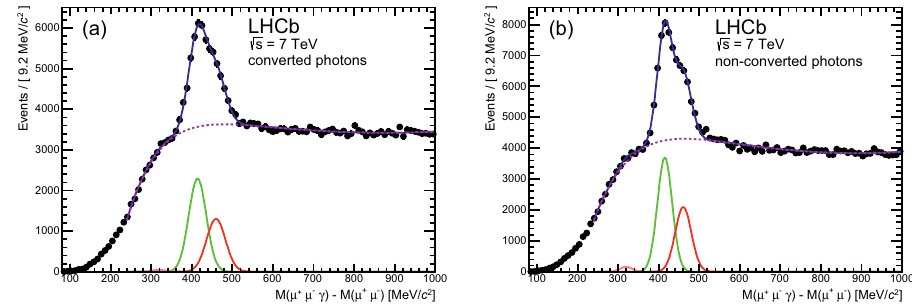
Figure 19. Distribution of the mass di ff erence Δ M = M ( μ + μ − γ ) − M ( μ + μ − ) for selected candidates with 3 < < 15GeV / c for (a) converted and (b) non-converted photons. The lower solid curves correspond to the χ p J /ψ T , χ c 1 and χ c 2 peaks from left to right, respectively. The background distribution is shown as a dashed curve. The upper solid curve corresponds to the overall fit